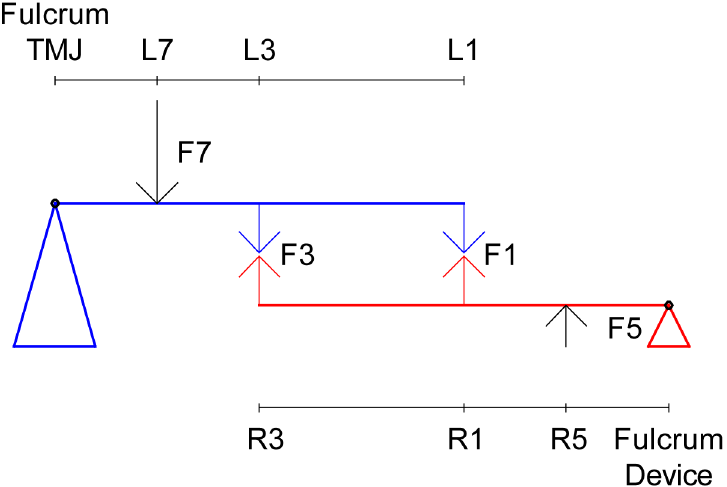
Figure A2. Schematic representation of upper component of the masticatory system (blue) and device (red) model system.